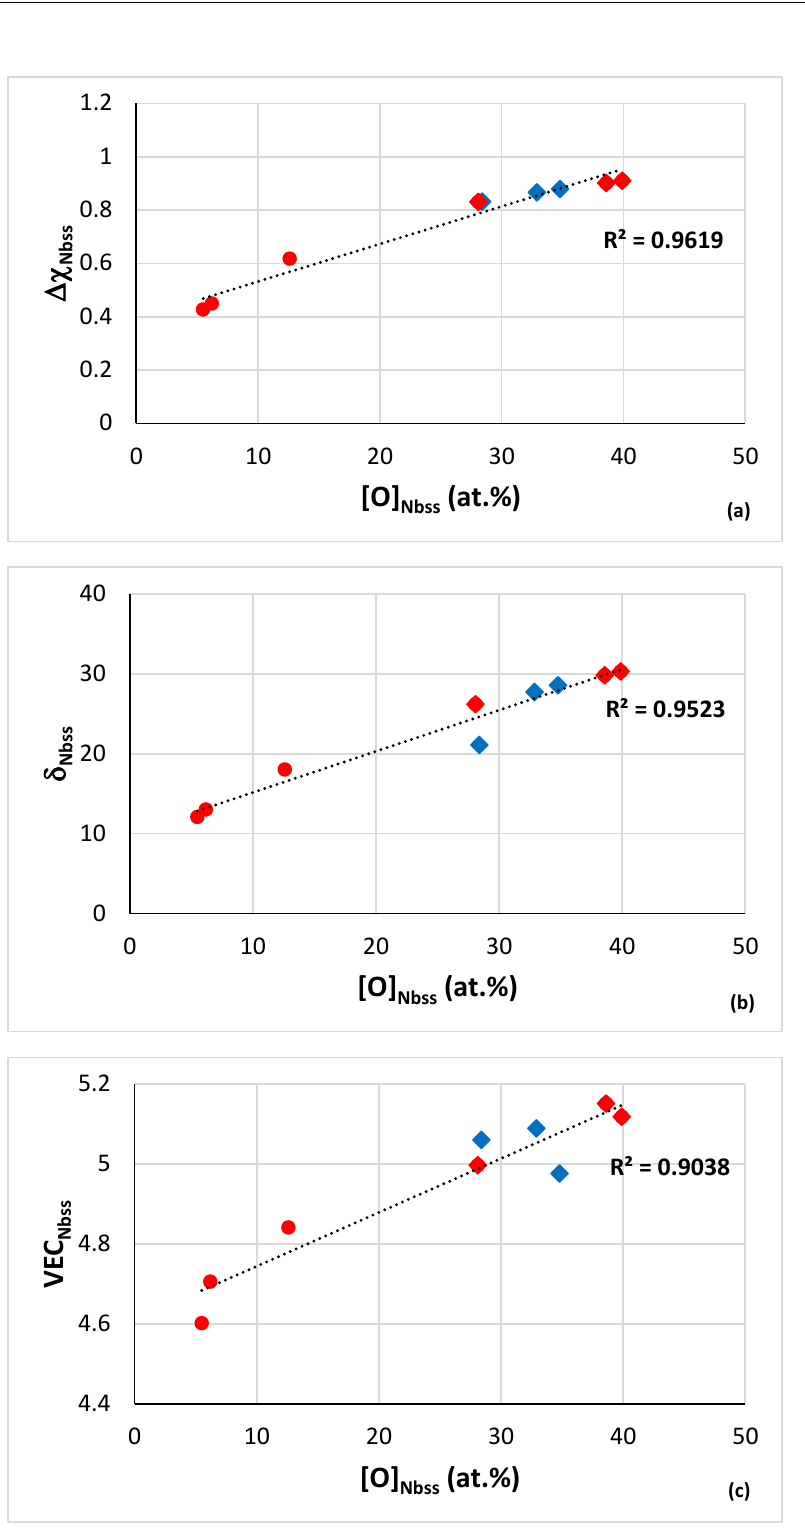
Figure 11. Relationships of the oxygen concentration in contaminated solid solutions in the diffusion zone and the bulk of alloys that were oxidised isothermally at 800 ◦ C. Oxygen concentration ( a ) versus ∆ χ δ Nbss ( b ) versus Nbss and ( c ) versus VEC Nbss . Colours: blue for Nb ss in diffusion zone (DZ) formed at 800 ◦ C and red for Nb ss in bulk of alloy isothermally oxidised at 800 ◦ C. Diamonds for CC/HE Nb ss . In each part the R 2 value is for the linear fit of all the data. Data for the alloys NV1, NV2, NV5, ZX5, ZX7. See Appendix A for nominal alloy compositions and